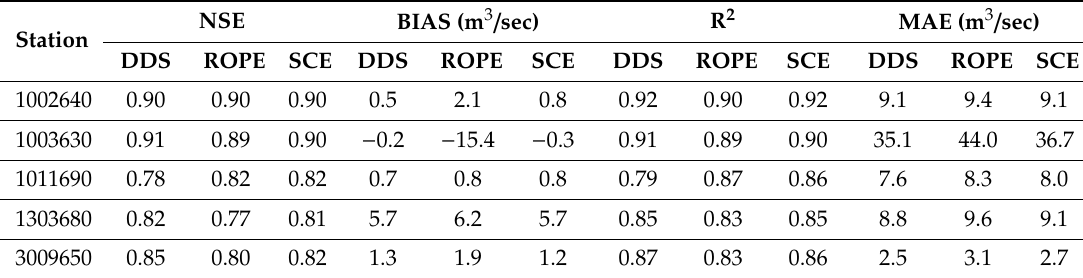
Table 2. Comparison of various performance measurements for the calibration stations with the number of iterations set to 20,000. The performance measurements include Nash–Sutcli ff e e ffi ciency (NSE), bias, coe ffi cient of determination ( R 2 ) and mean absolute error (MAE).